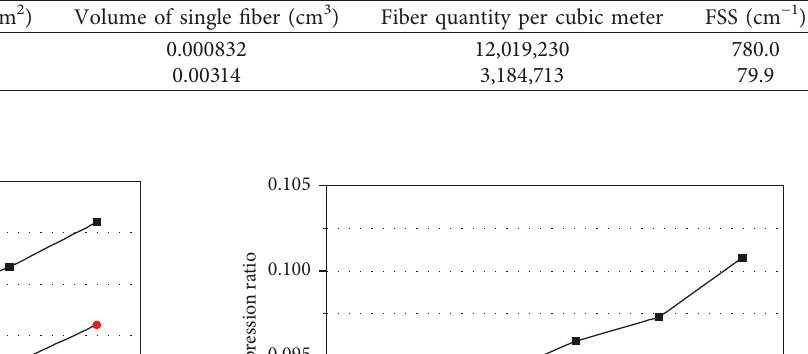
Table 6: Comparison of the number of fibers per cubic meter.